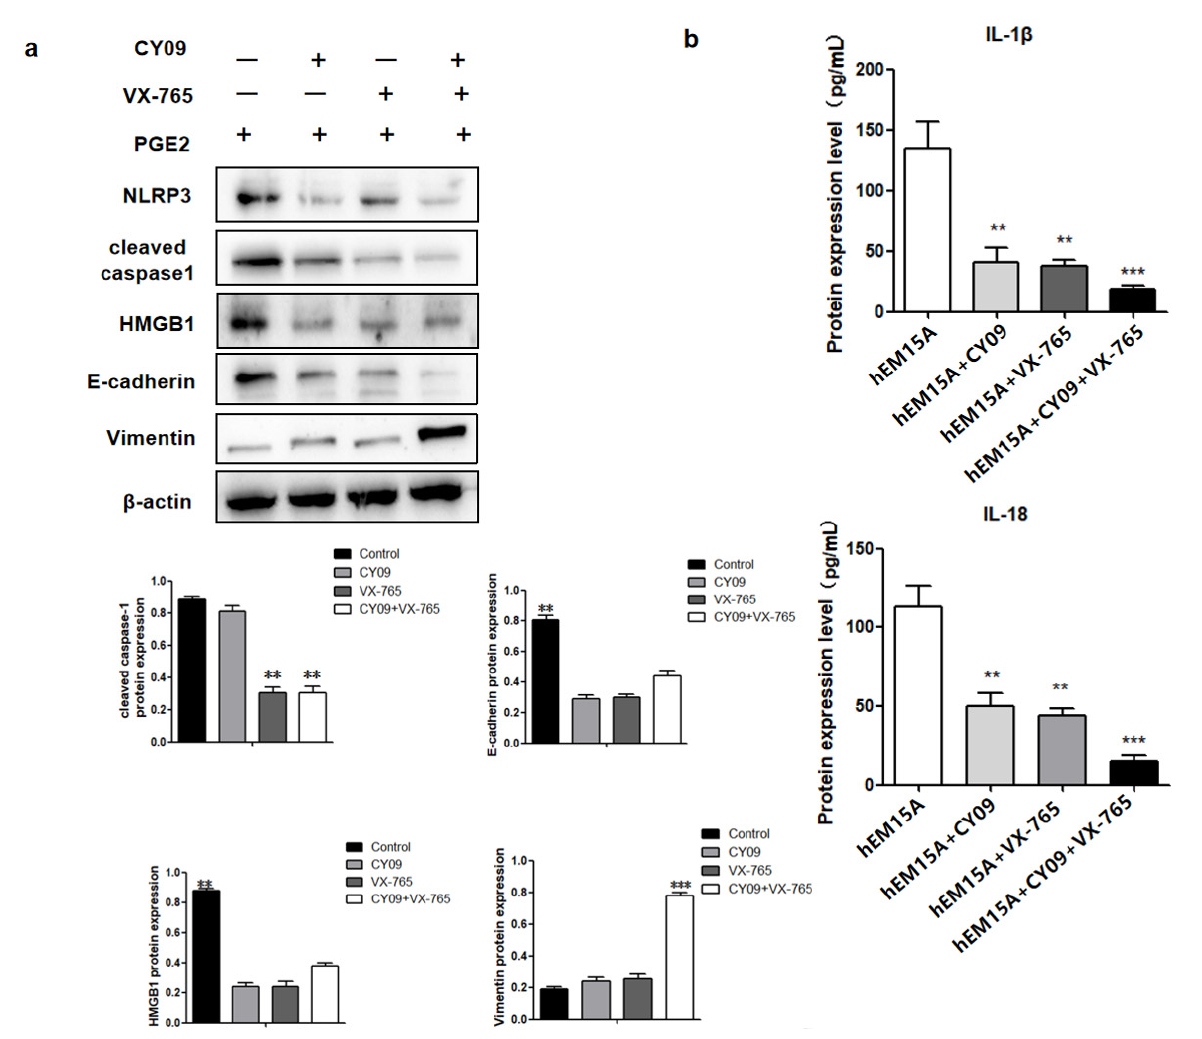
Figure 5. PEG2-induced pyroptosis regulates the expression of HMGB1 and promotes hEM15A migration ability. ( a ) In hEM15A, PGE2, co-cultured PGE2 + CY-09 (the inhibitor of NLRP3), co-cultured PGE2 + VX-765 (the inhibitor of caspase-1) and co-cultured PGE2 + CY-09 + VX-765, the protein of NLRP3, cleaved caspased1, HMGB1, E-cadherin and Vimentin were detected by Western blot analysis. ( b ) In hEM15A, PGE2, co-cultured PGE2 + CY-09 (the inhibitor of NLRP3), co-cultured PGE2 + VX-765 (the inhibitor of caspase-1) and co-cultured PGE2 + CY-09 + VX-765, the level of IL-1 β and IL-18 in cell culture medium were detected by ELISA in hEM15A and hESC. The data are expressed as means ± SEM. ** p < 0.05, *** p < 0.001 by one-way ANOVA.